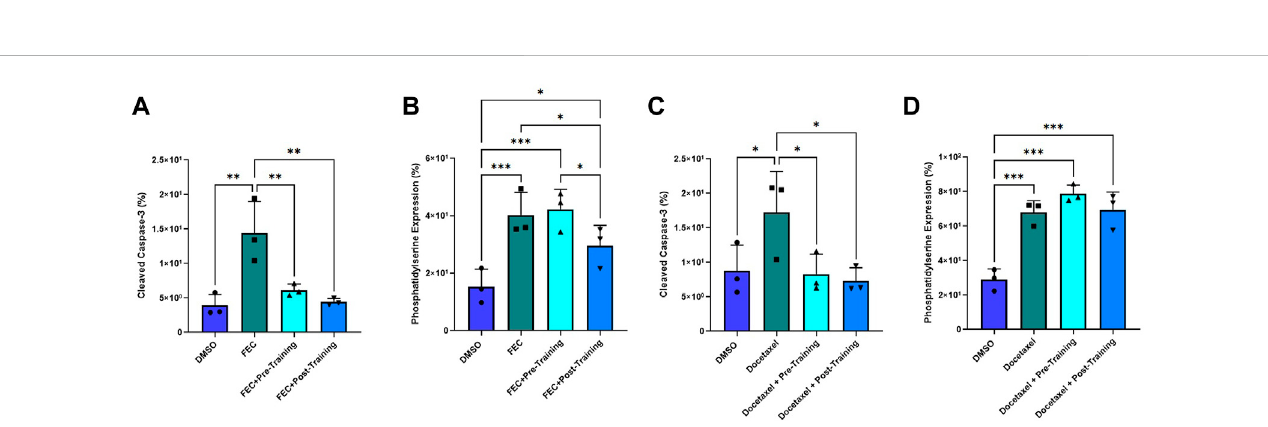
FIGURE 6 Comparison of pre- and post-exercise intervention serum preconditioning on the effects of FEC (A,B) : 5- fl uorouracil: 1.5 µM, epirubicin: 0.006 µM, cyclophosphamide: 38 µM) and 6 µM docetaxel (C,D) exposure on human coronary artery endothelial cells (HCAEC) phosphatidylserine (A,C) and cleaved caspase-3 expression (B,D) at 4- and 48-h post-exposure, respectively. Data shown are mean ± SEM ( n = 3). * p < 0.05, ** p < 0.01, *** p <